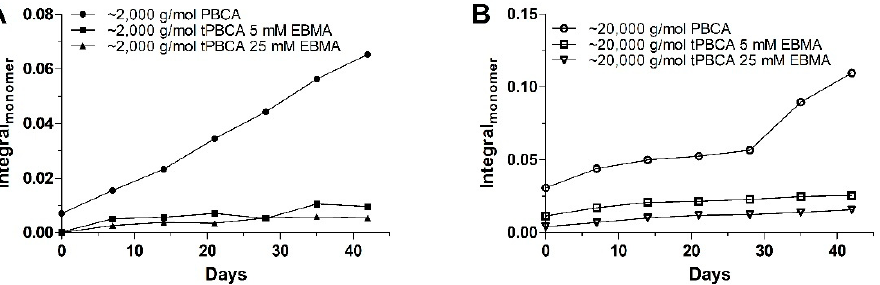
Figure 10. Monomer release monitored in 1 H NMR measurements at 7.058 ppm (m) for PBCA and tPBCA. tPBCA was terminated using two different EBMA concentrations, 5 mM and 25 mM. PBCA and tPBCA having a MW of ~2000 g/mol ( A ) and ~20,000 g/mol ( B ) were stored for seven weeks in CDCl 3 solution.